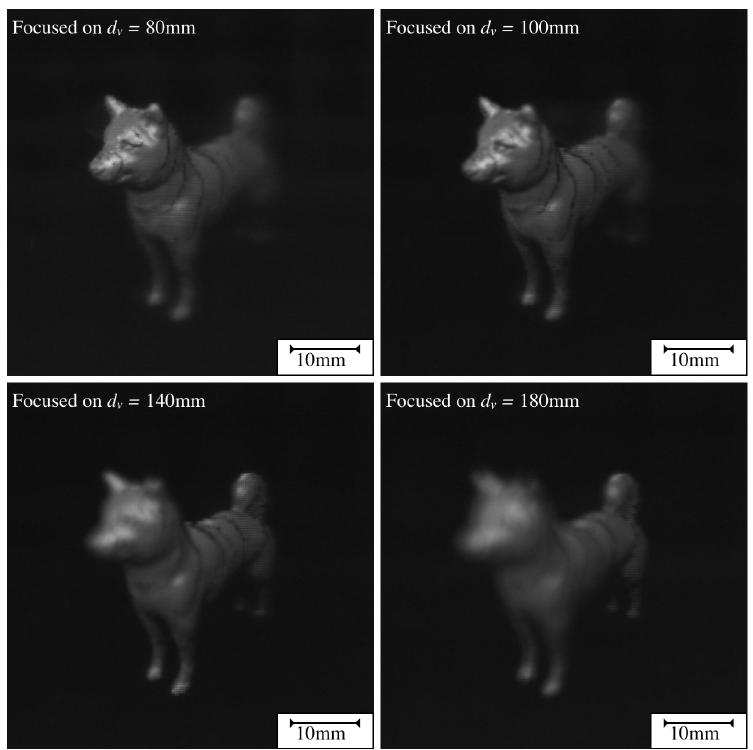
Figure 6. 3D model of the dog displayed with the proposed system. For any of the displayed images, we added up 11 individually captured depth images. The camera’s objective focuses on the corresponding depth